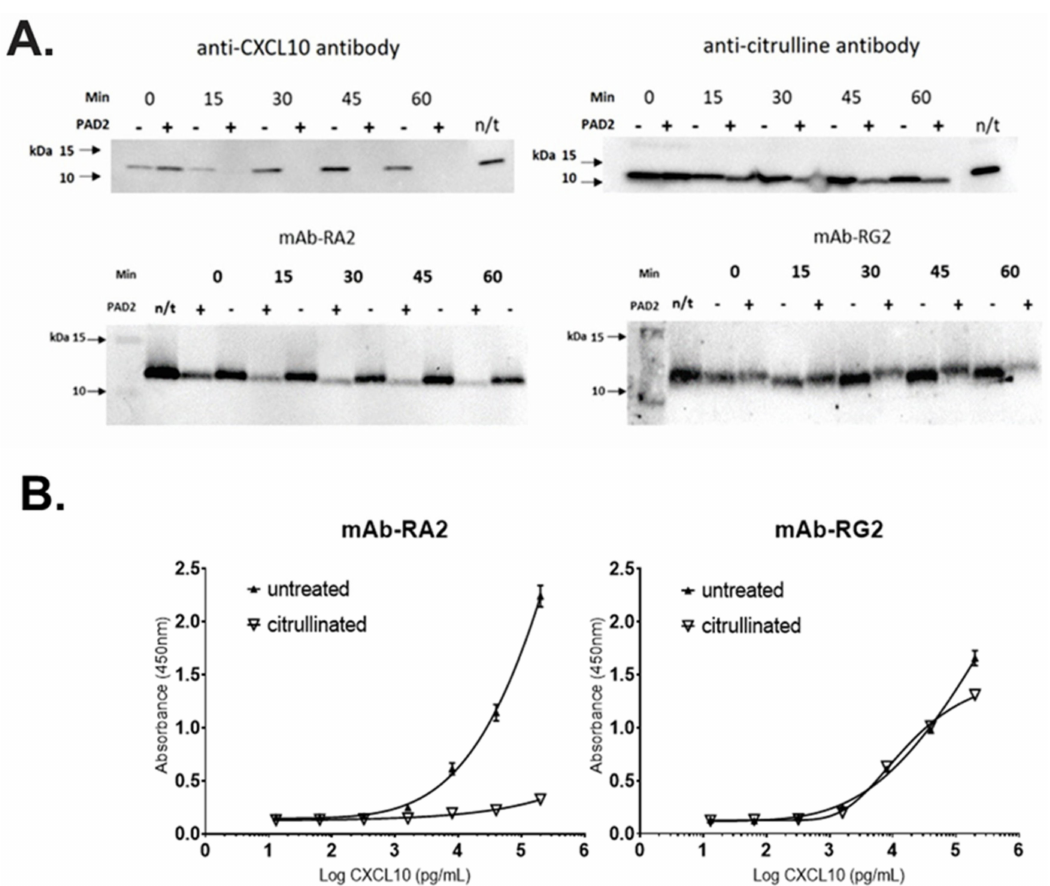
Figure 3. ART successfully discriminated citrullinated from non-citrullinated CXCL10. ( A ) In vitro citrullination of recombinant, full length CXCL10 by PAD2 resulted in loss of detection by commercial anti-CXCL10 antibody ab9807 (upper left), and a substantial reduction in detection by mAb-A2 (lower left). Citrullination was confirmed using an anti-citrulline antibody (upper right). Detection of citrullinated CXCL10 by mAb-RG2 was unaffected. ( B ) ELISA using mAb-RA2 (left) or mAb-RG2 (right) confirmed that detection of citrullinated CXCL10 by mAb-RA2 was abrogated, whilst detection by mAb-RG2 was unaffected. n = 3 replicates per data